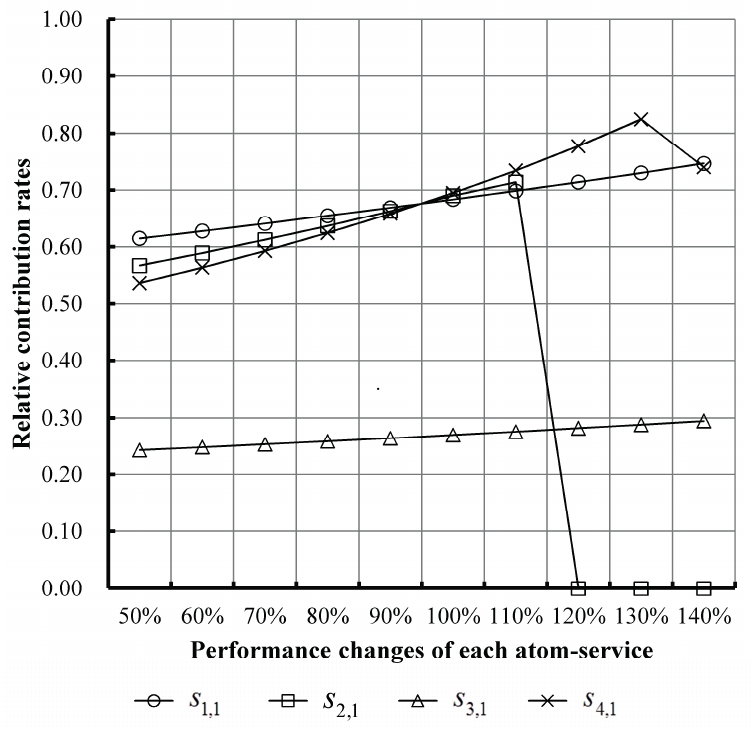
Figure 10. Relative contribution rates on total performance of the SCA instance by each